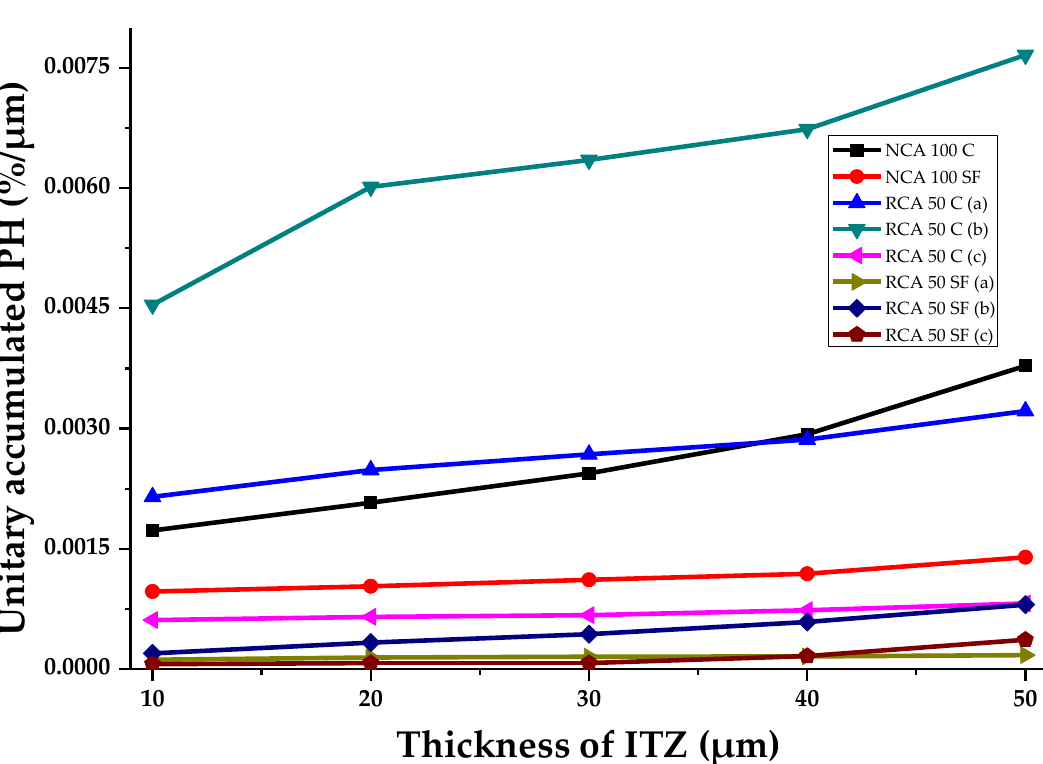
Figure 13. Hydration products of the samples analyzed in the IZT with various theoretical thicknesses.